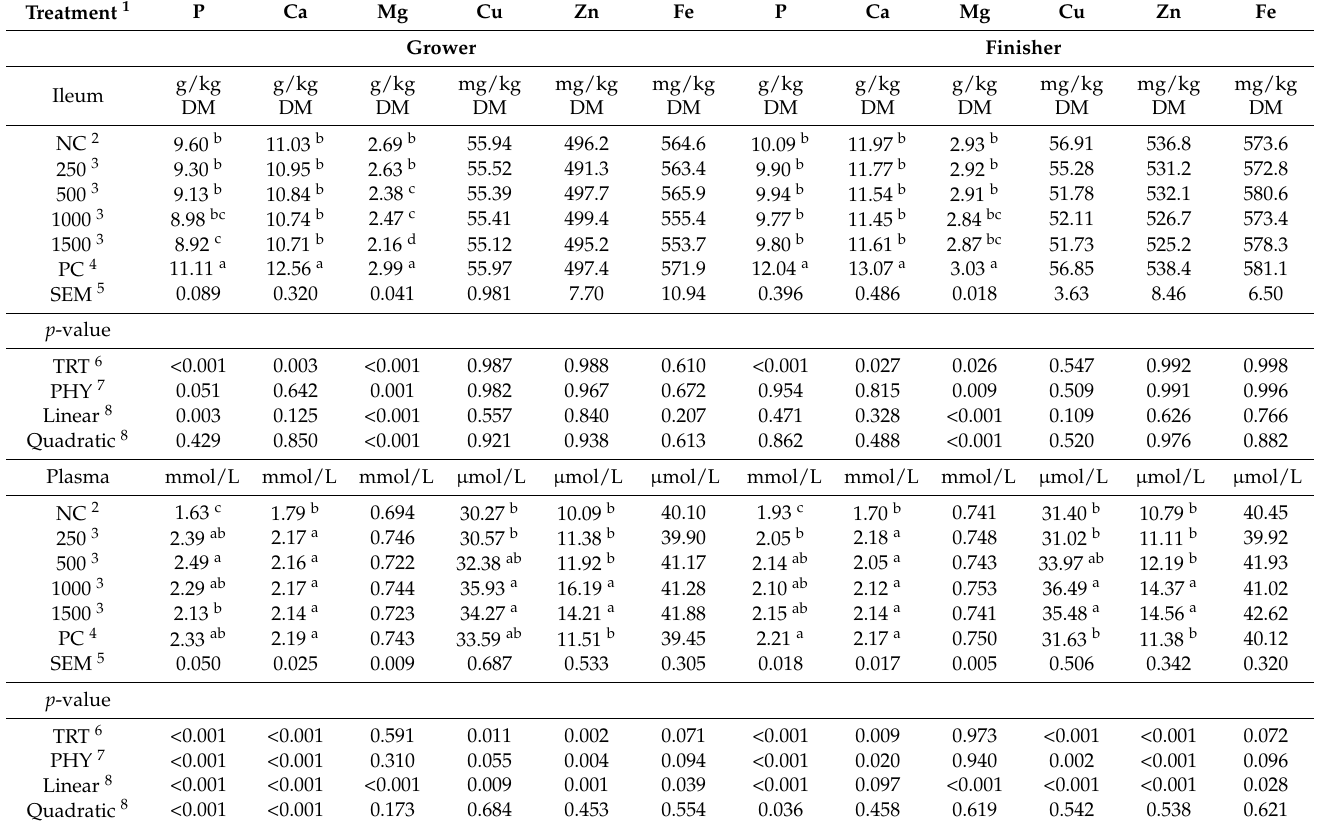
Table 2. Mineral content in the ileum and blood plasma of growing–finishing